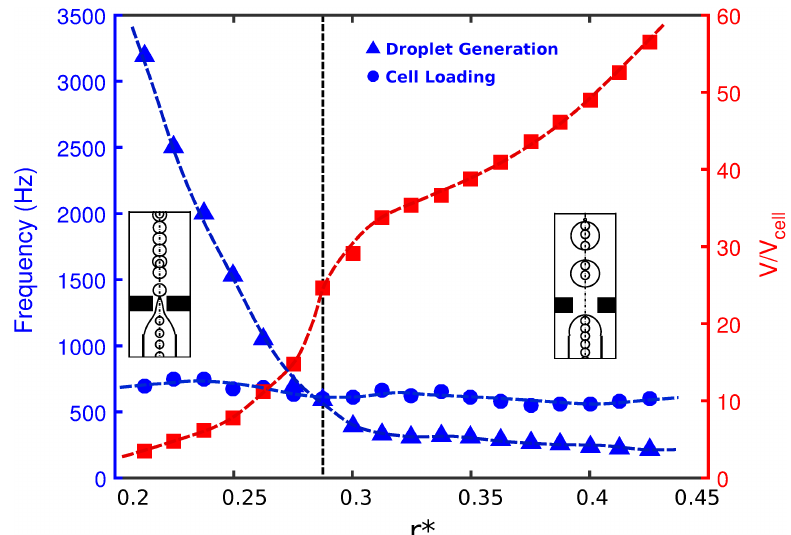
Figure 3. Frequency of droplet generation (triangles) versus frequency of cell loading (circles) and non-dimensional droplet size (squares) for configurations with different non-dimensional orifice radii at Ca i = Ca o = 10 − 3 . Other geometrical parameters are kept fixed ( l ∗ = 0.5 and d ∗ = 0.75).